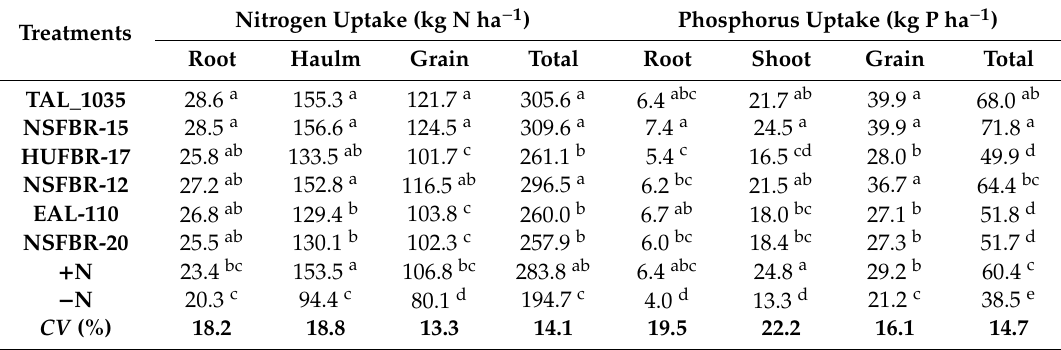
Table 5. Root, haulm and grain nitrogen and phosphorus uptakes in faba bean inoculated with di ff erent rhizobium strains.